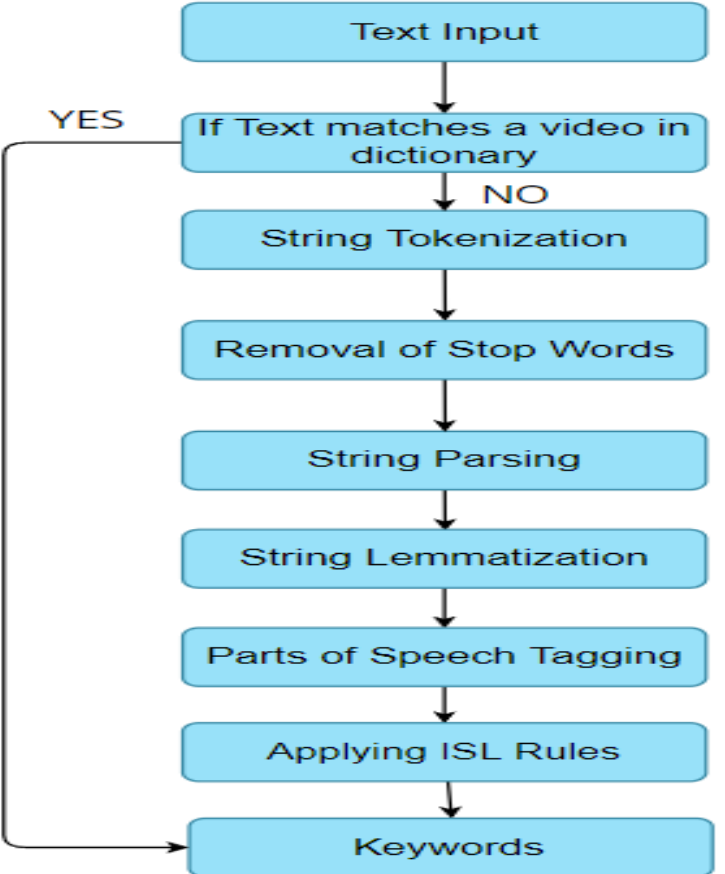
Figure 6. Natural Language Model Architecture.